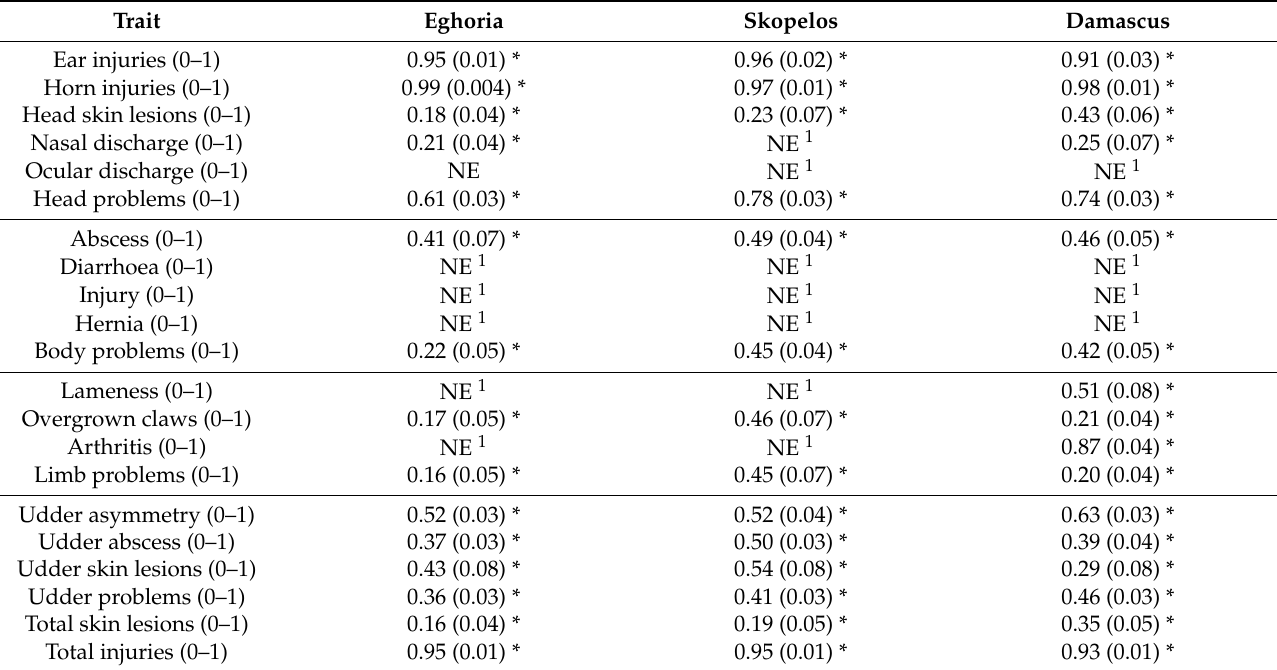
Table 6. Repeatability estimates (standard error in parentheses) for welfare traits in Eghoria, Skopelos, and Damascus